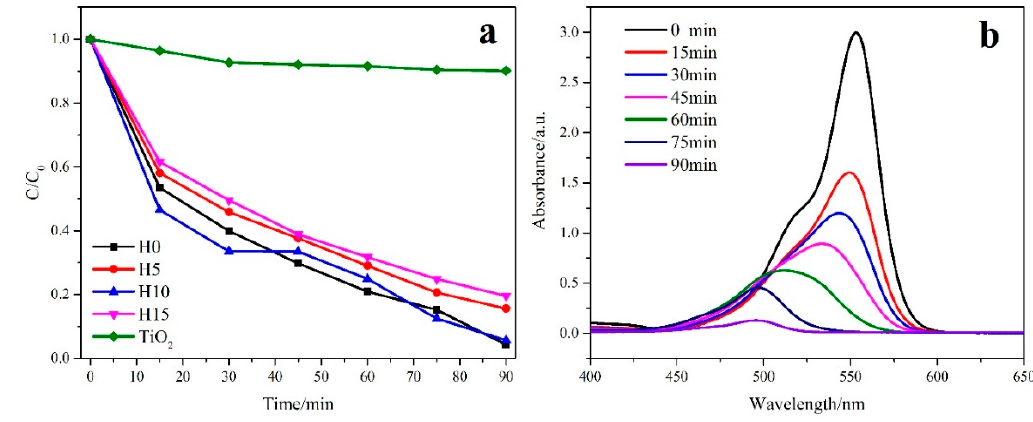
Figure 5. Photocatalytic activity of Bi 2 WO 6 samples ( a ) prepared using different HNO 3 concentrations, ( b ) as well as their UV spectrum.